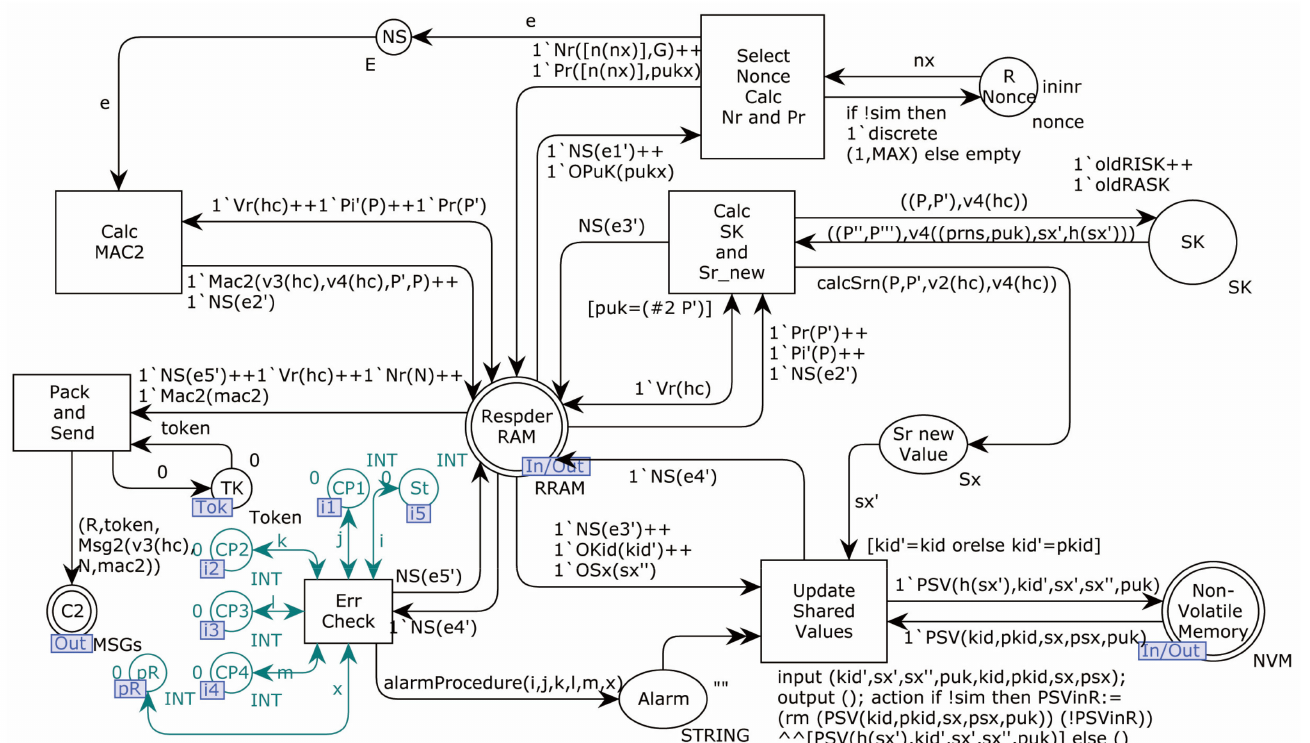
Figure 10. Responder model sub-page